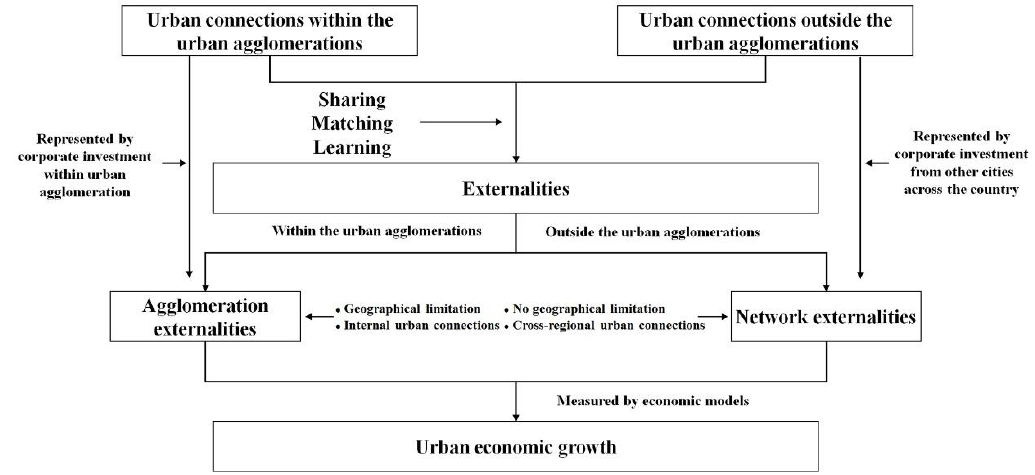
Figure 1. The f ramework of the research on the externalities of urban agglomerations. Figure 1. The framework of the research on the externalities of urban